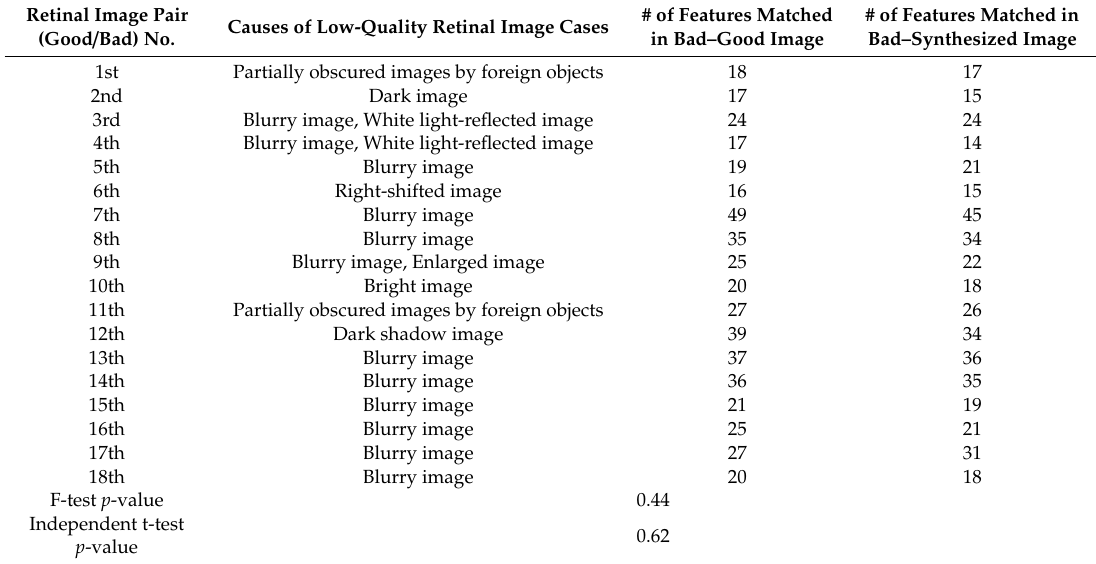
Table 1. Comparative analysis from feature matching. Retinal Image Pair (Good / Bad) No.